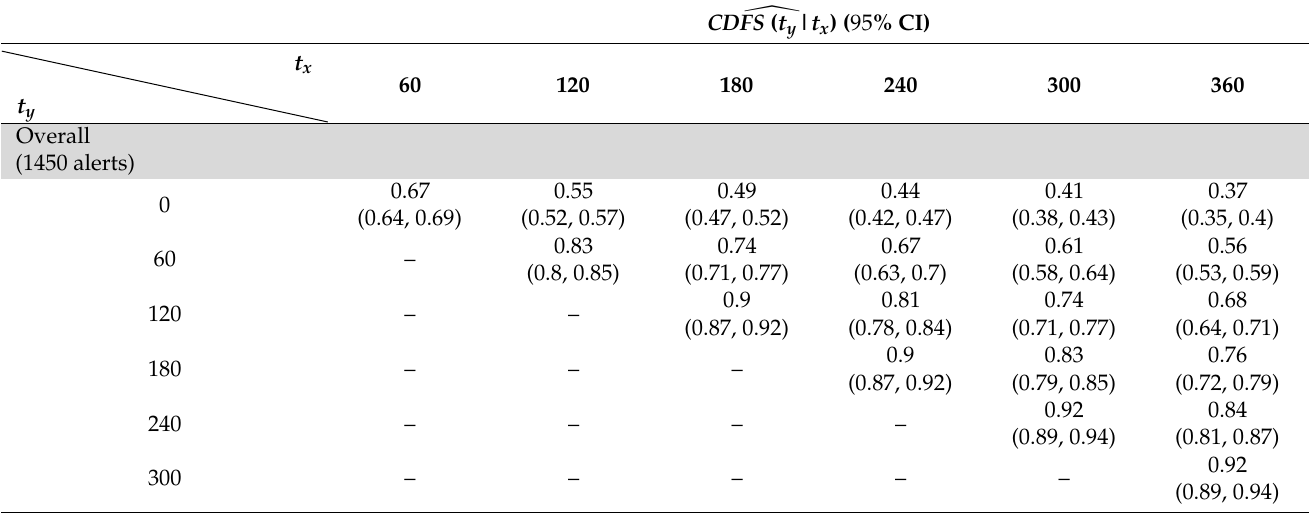
Table 1. An overview of estimated overall conditional defect free survival probabilities, and their corresponding 95% confidence intervals (CI), to various timestamps in minutes t y , conditioned on APA being defect free until timestamps t x upon triggering the alert. Note: t x = 0 denotes the baseline time, i.e., the time of alert generation.